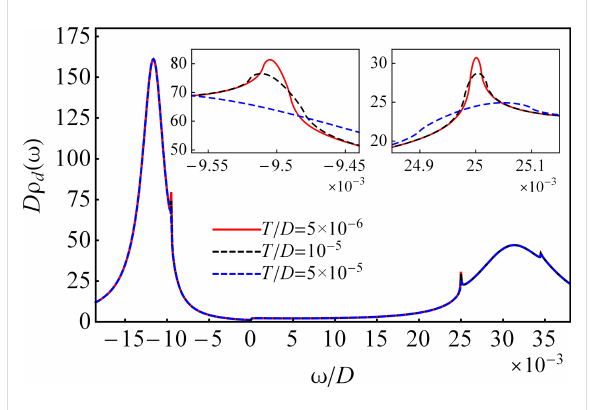
Figure 9: The nonequilibrium DOS in the QD for U / D = 0.069 with